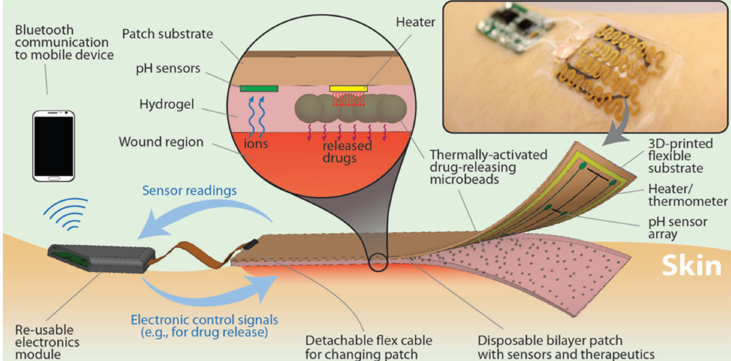
Figure 5. Schematic and conceptual view of the automated smart bandage. The bandage was comprised of an array of flexible pH sensors and a flexible heater to trigger thermo-responsive drug carriers containing antibiotics. Thermo-responsive drug carriers were embedded in a layer of alginate hydrogel which was cast around the pH sensors and on top of the flexible heater. The sensors and heater were connected to an electronic module that could record the sensors signal and power the heater if needed. The electronic module could also communicate wirelessly to computers and smartphones Reprinted (adapted) with permission from Reference [8]. Copyright 2021 John Wiley and